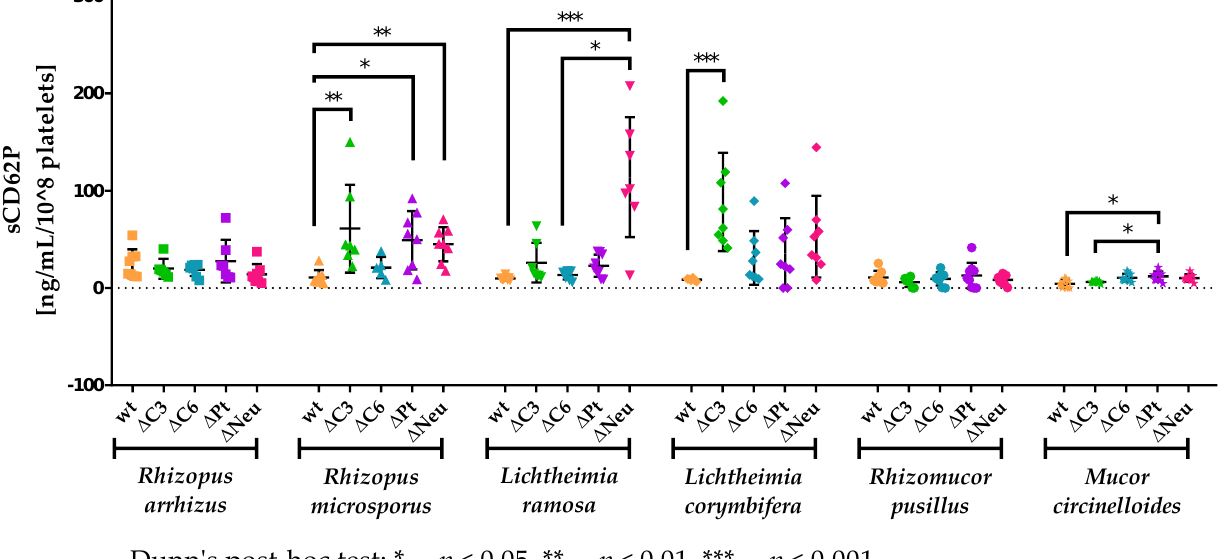
Figure 6. Normalized plasma levels of soluble P-selectin (sCD62P) in a murine model of disseminated mucormycosis. Immunocompetent (wt, n = 9), C3-deficient ( ∆ C3, n = 9), C6-deficient ( ∆ C6, n = 9), thrombocytopenic ( ∆ Pt, n = 9), and neutropenic ( ∆ Neu, n = 9) animals were intravenously challenged with 5 × 10 5 spores of R. arrhizus , R. microsporus , L. ramosa , L. corymbifera , Rh. pusillus , or M. circinelloides . Soluble P-selectin levels were measured using serum retrieved from animals at the day of exitus and normalized to the amount of 10 8 platelets measured at the same time point using whole blood. Asterisks (*) indicate the level of significance for an adjusted p -value, comparing pairs of groups within a fungal species using a Dunn’s post-hoc test after the Kruskal–Wallis test reported significance.